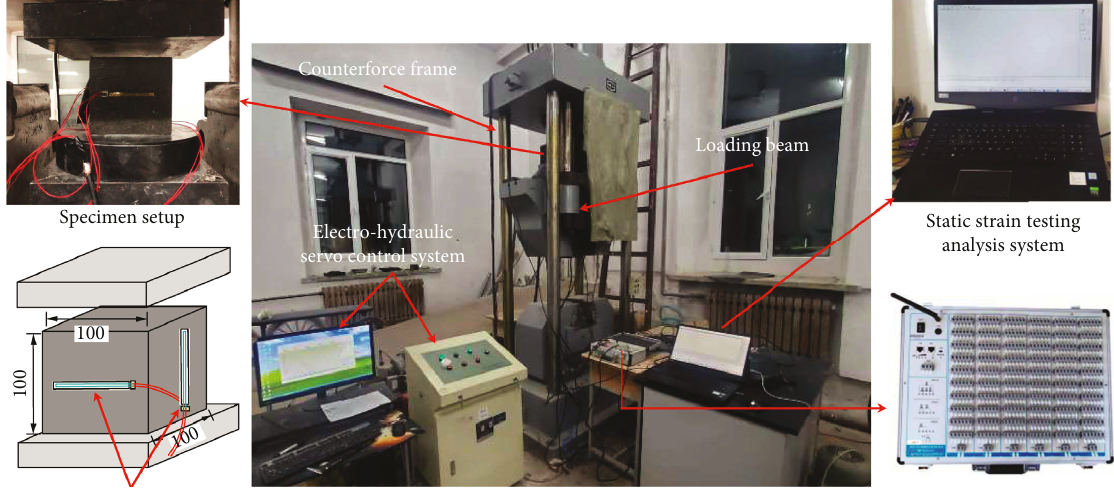
Figure 4: Compressive strength